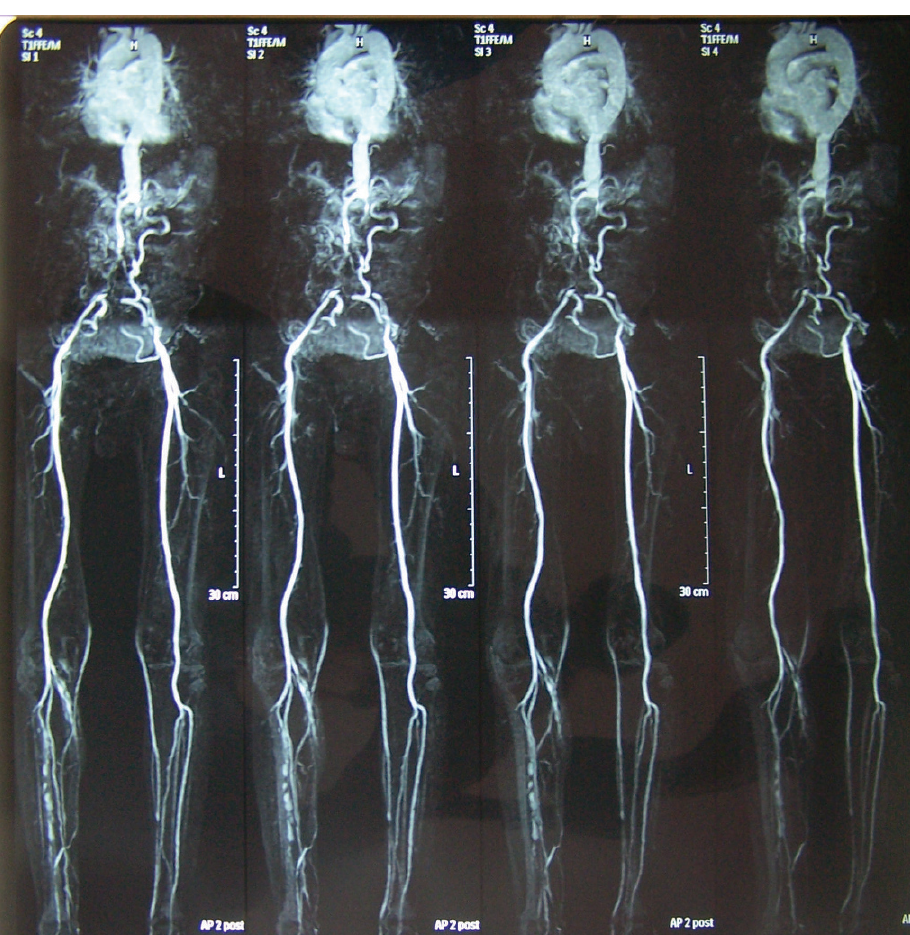
Figure 1 - Magnetic resonance angiography of the abdominal vessels, which reveals total occlusion of the abdominal aorta just below superior mesenteric artery. The lower extremities and the abdomen are perfused by means of the collateral